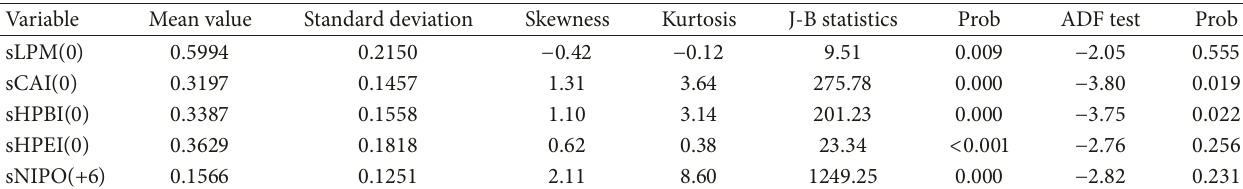
Table 1: Descriptive statistical results of indexes after pretreatment.